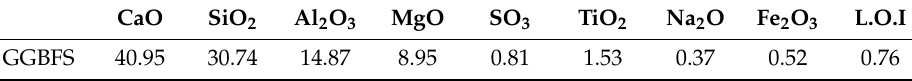
Table 1. Chemical composition of Ground-granulated blast furnace slag (GGBFS) (wt.%).